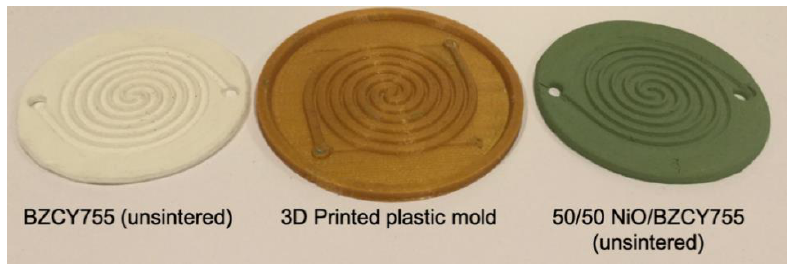
Figure 1. The 3D printed mold ( center ), molded parts BZCY755 ( left ) BZCY755/NiO ( right